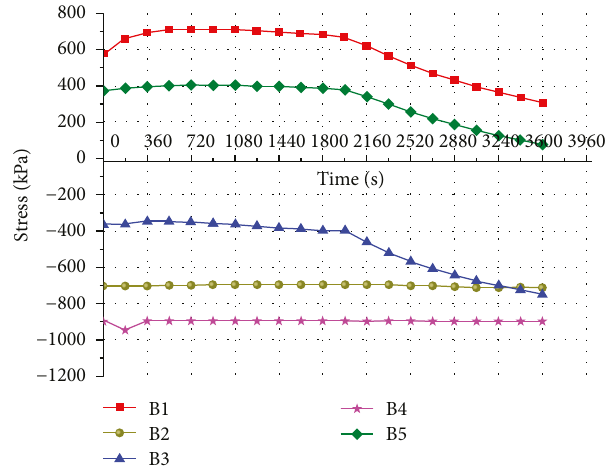
Figure 22: Stress-time curves of B1 – B5.